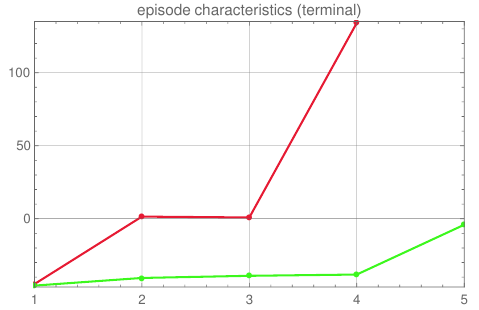
(b) Two-dimensional projection of the charge matrices Q t of the episode connecting the ini- tial state (4.14) (yellow dot) with the final state (4.13) (red dot). The labels indicate the intrinsic values.